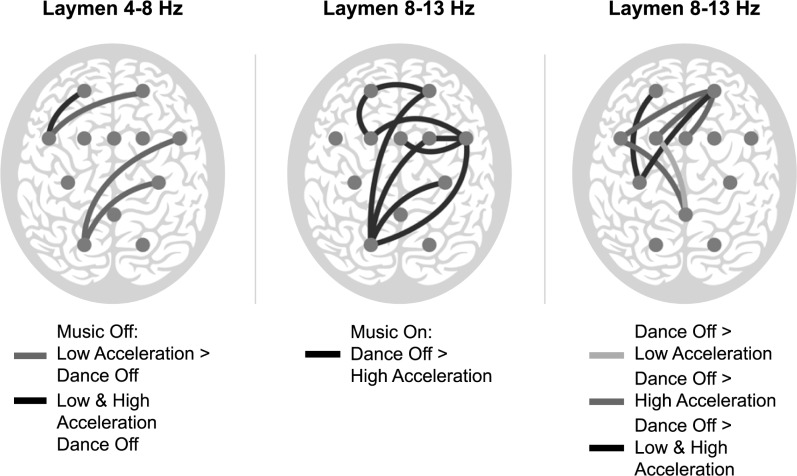
Significant differences for the Dance*Music interaction (Dance Off, Low Acceleration, High Acceleration; Music Off, Music Off) and the main factor of Music (Music On, Music Off) for laymen in the theta (4–8 Hz; on left) and alpha (8–13 Hz; in the middle Dance*Music interaction during Music On; on right main of factor Music) bands.The colour coding of the lines which connect the electrode pairs with significant differences is explained next to each image. Each gray dot illustrates the location of an EEG electrode on the scalp.